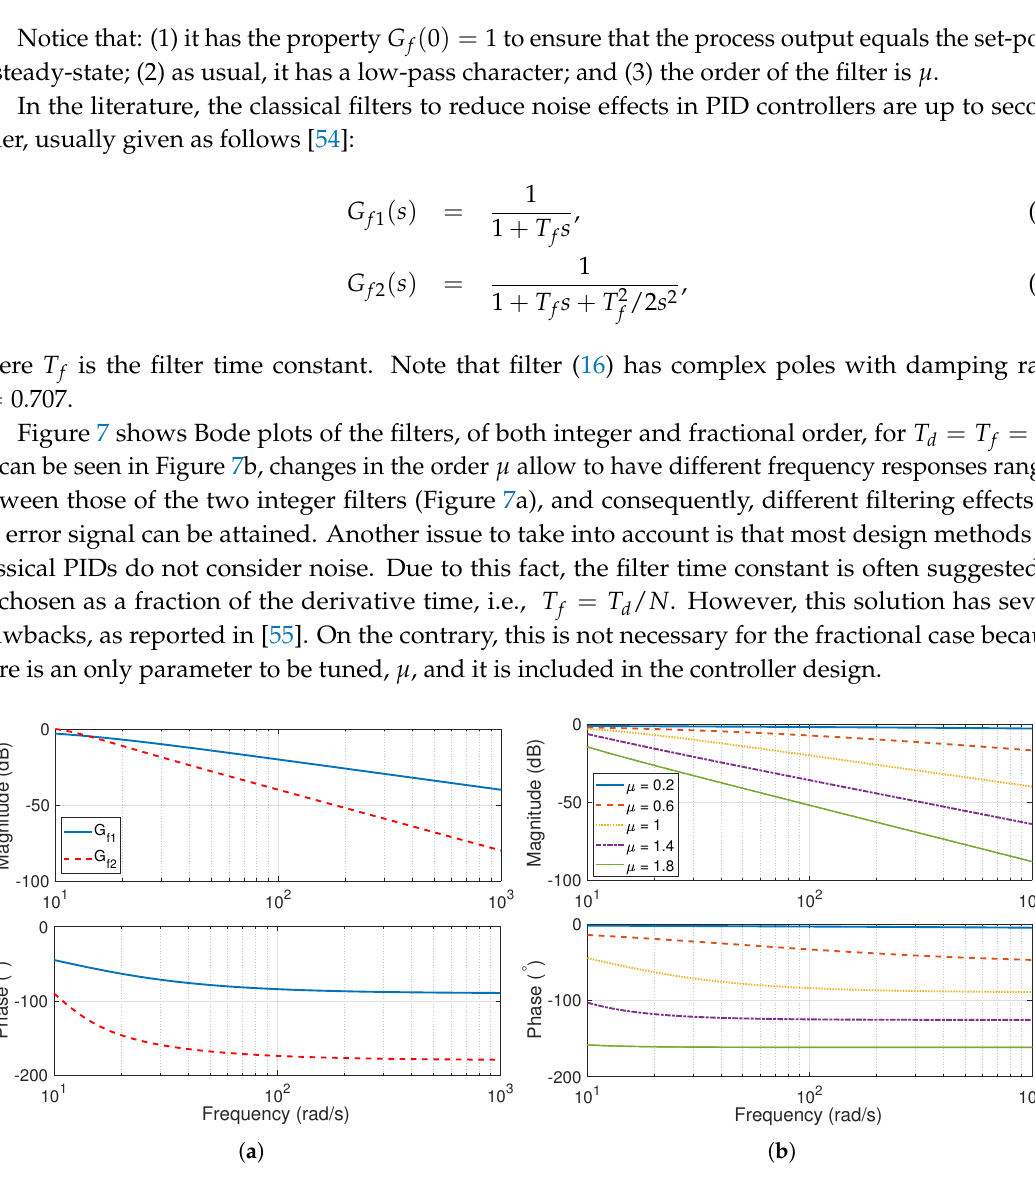
Figure 7. Frequency response of the noise filter: ( a ) first and second order low-pass filters (integer case) ( b ) fractional filter for different values of µ (fractional case). For simulations, the following values were taken: T d = T f =